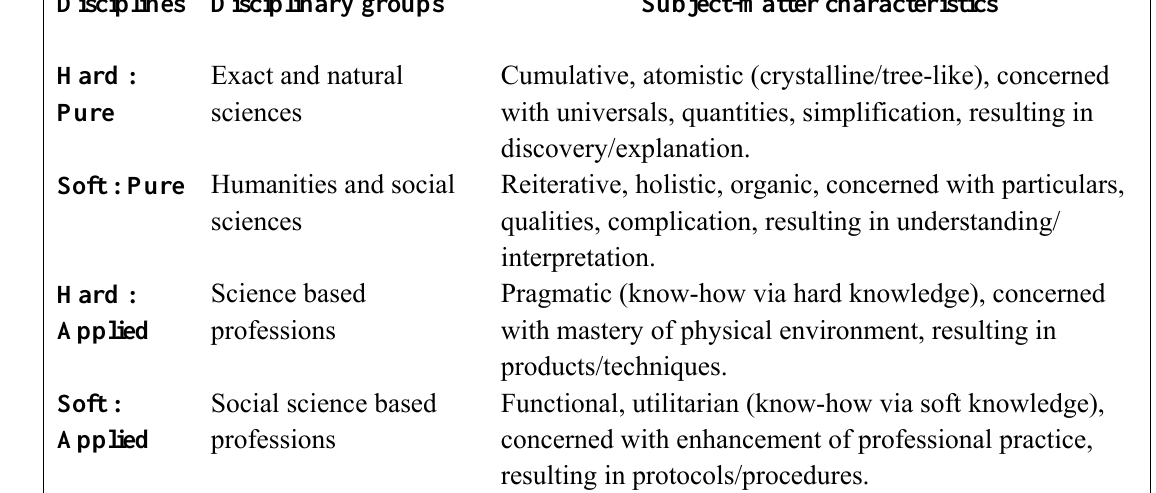
Biglan's (1973) Classification of Disciplines and their Subject-Matter Characteristics Disciplines Disciplinary